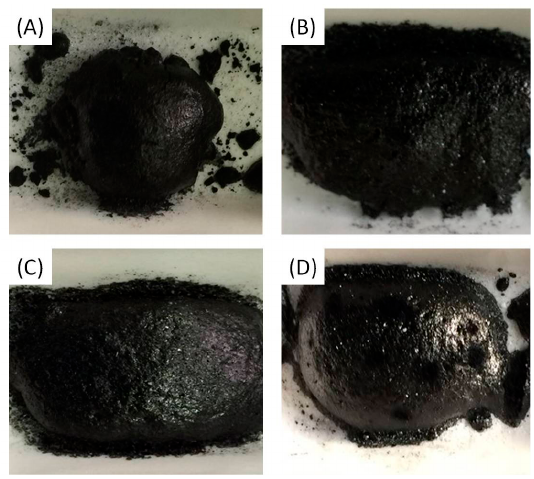
Figure 3. Photographs of porous carbon, ( A ) PC-0, ( B ) PC-1, ( C ) PC-5, ( D )